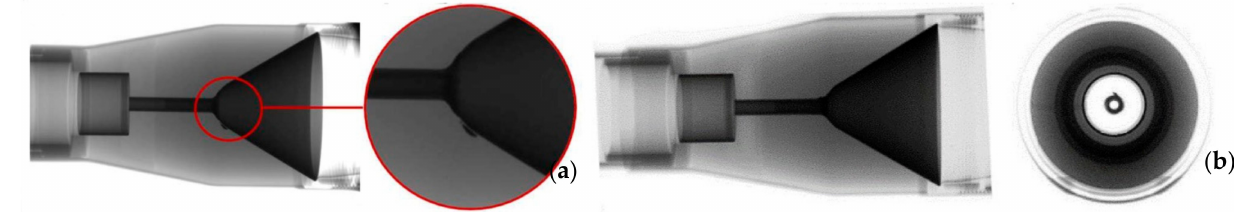
Figure 2. Examples of RTR X-ray images of a PG-7VM warhead showing its axial and radial cross-section: ( a ) foreign body in explosive; ( b ) warhead without discrepancies.